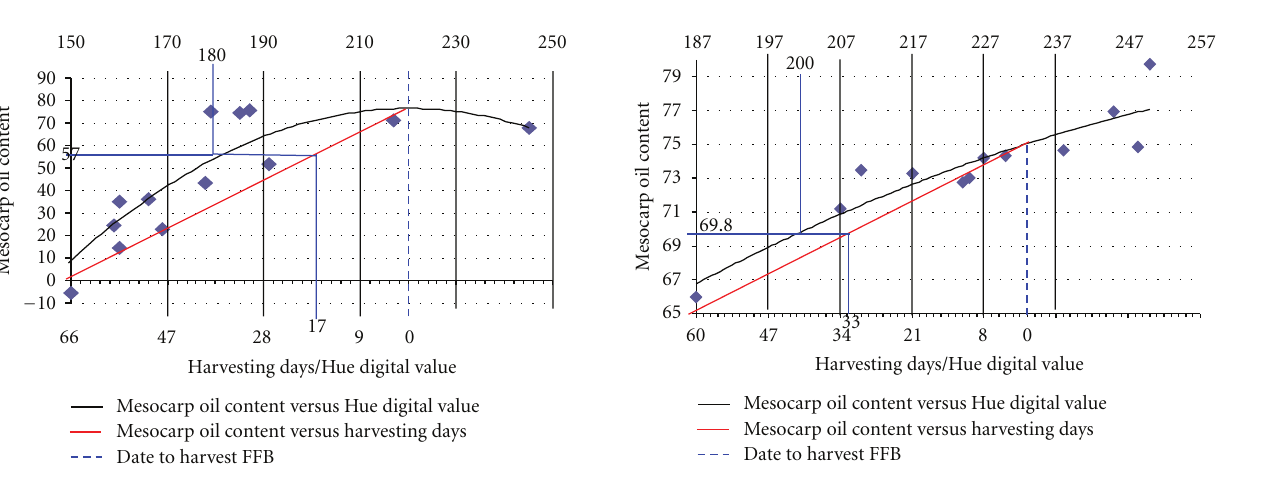
Figure 10: The model of the harvesting days for FFB 16 years old oil palm tree.